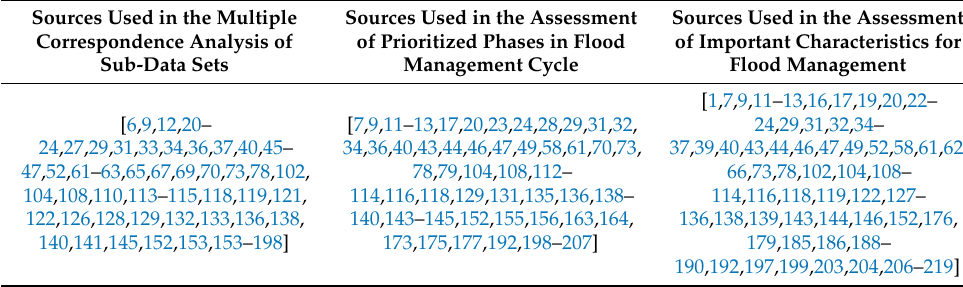
Table A1. List of references used in the systematic literature review, for the MCA, phases of flood risk management cycle, and important characteristics for flood management.